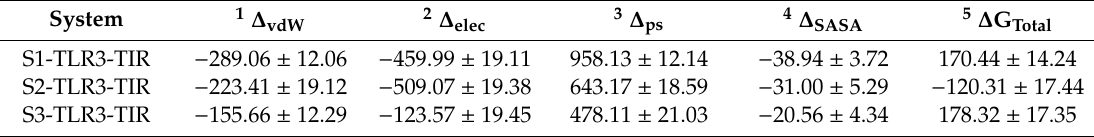
Table 6. Decomposition of the binding free energy (kJ mol − 1 ) between TIR